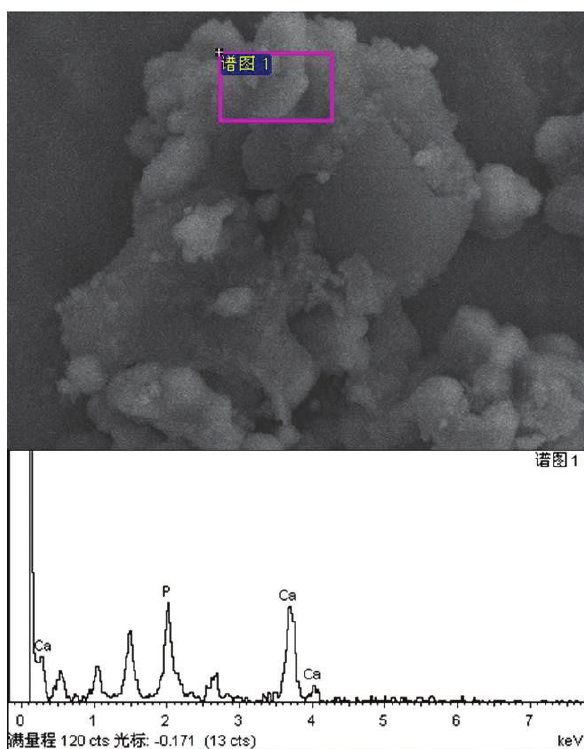
Figure 8: SEM picture and EDS analysis of HA-PETRA microspheres after melting.